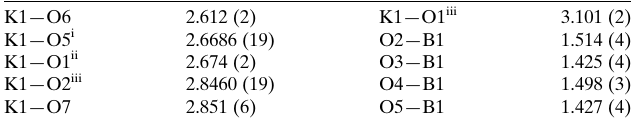
Table 1 Selected bond lengths (A˚ ).